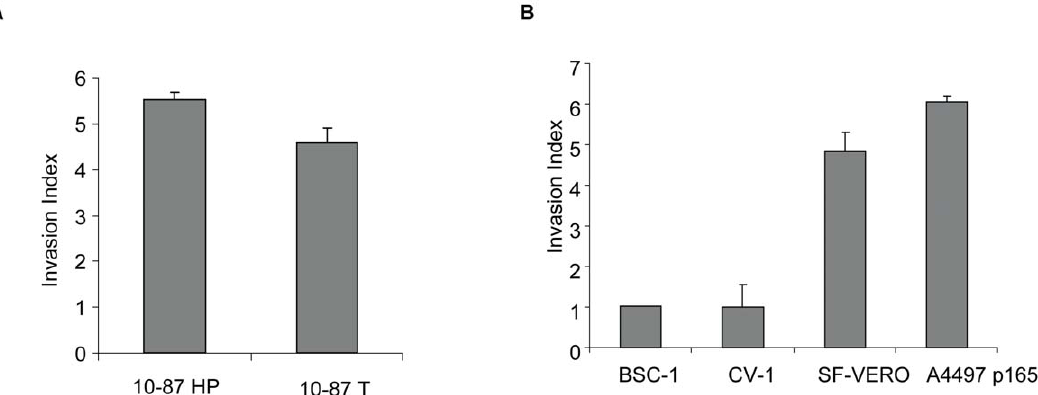
Figure 2. Matrigel-invasion assay with African green monkey kidney lines. (A)10-87 HP and 10-87 T; (B) BSC-1, CV-1, SF-VERO, and A4497. The cells were placed in a Matrigel-invasion chamber, and cells that invaded the Matrigel were fixed, stained, and counted. Test and control (10-87 LP) cells that invaded the Matrigel were counted in 5 fields under a 20 6 objective. The data were expressed as fold percent invasion of 10-87 LP cells. The mean data are plotted with their standard deviations.